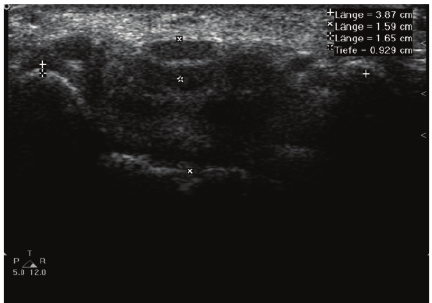
Figure 1: Internal wrist measurement: the radio-ulnar (width) distance between the pisiform (+) and scaphoid tubercle (+) and the dorsopalmar (depth) distance between the flexor retinaculum above the median nerve (𝑥) and the lunate bone (𝑥) were measured sonographically in the carpal